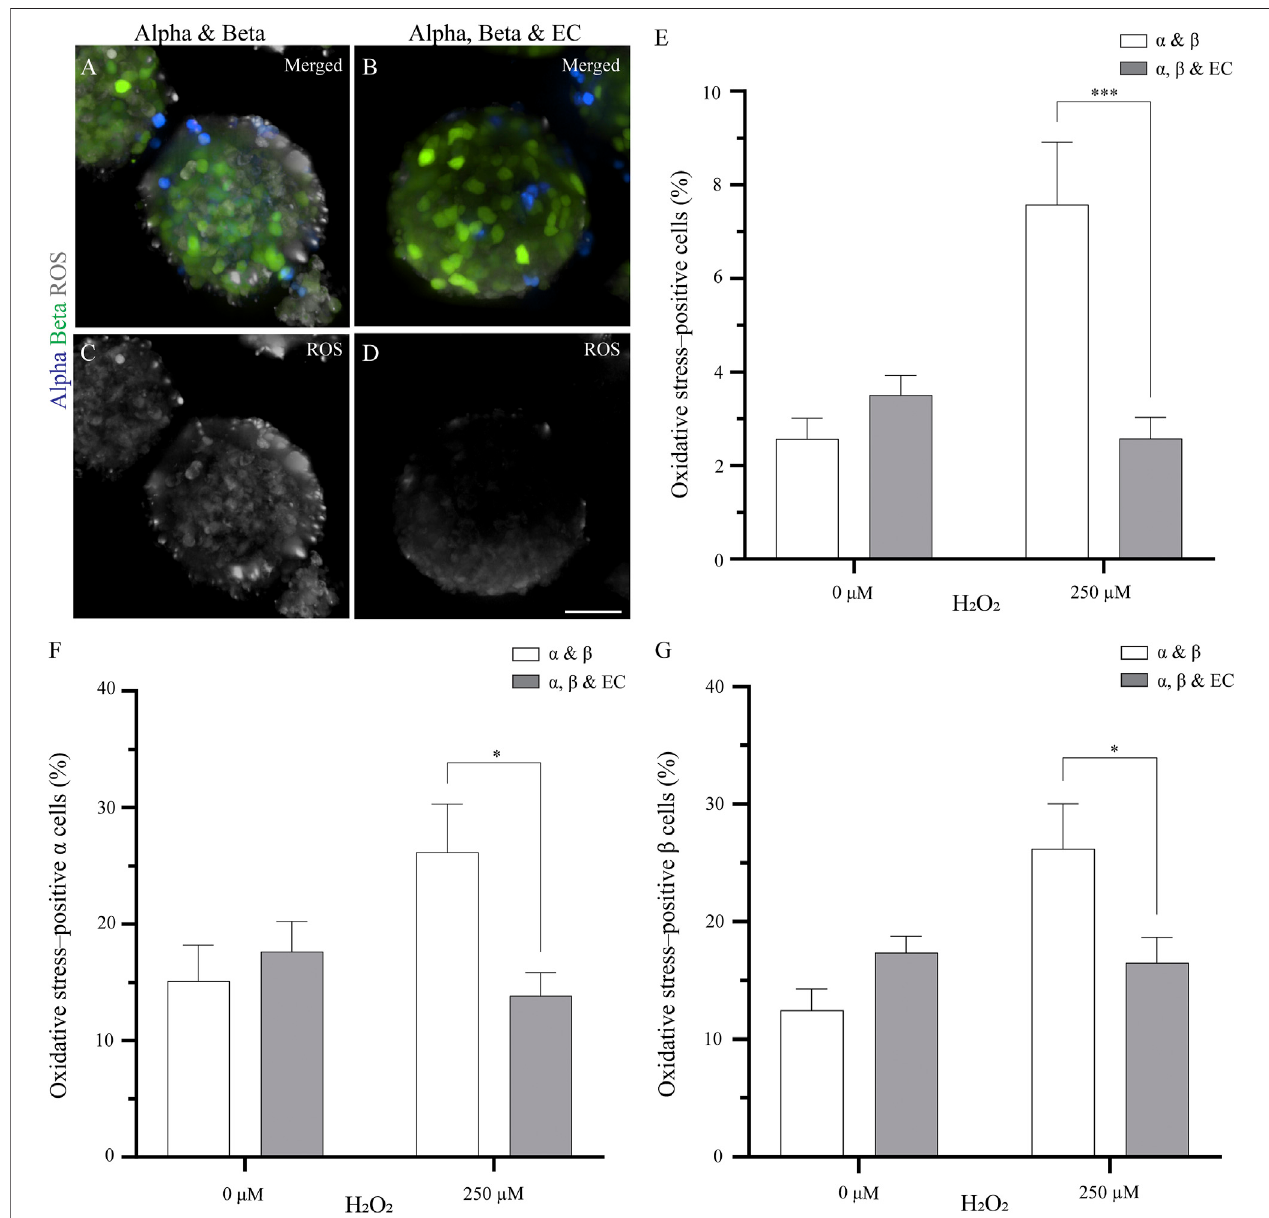
FIGURE1| Theadditionofendothelialcellsinthepseudoisletreducestheoxidativestressin α and β cells (A,B) FluorescenceimagingrevealsROS-positivecellsin samples that were exposed to 250 µM H 2 O 2 , showing α cells (blue), β cells (green) and ROS (grey) (C, D) Oxidative stress varies in pseudoislets with and without endothelial cells. A lower percentage of oxidative stress-positive cells are found in the pseudoislets including endothelial cells. Scale bars: 50 µm (E) After 5 days in culture,theendothelialcellsdecreaseoxidativestress(*** p < 0.001) (F) Thepresenceofendothelialcellsinthepseudoisletdidnotaffectthepercentageofoxidative stress-positive α cellsinthebasalmedia,howeverwheninducedbyH 2 O 2 ,asigni fi cantdecreaseofoxidativestress-positive α cellswasseen(* p < 0.04) (G) Theinclusion of endothelial cells in the pseudoislet reduced the percentage of oxidative stress-positive β cells upon induction by H 2 O 2 (* p < 0.04). Results are expressed as mean ± SEM, and each data set includes twelve pseudoislets (n:12), and the experiment was repeated three times (N:3).